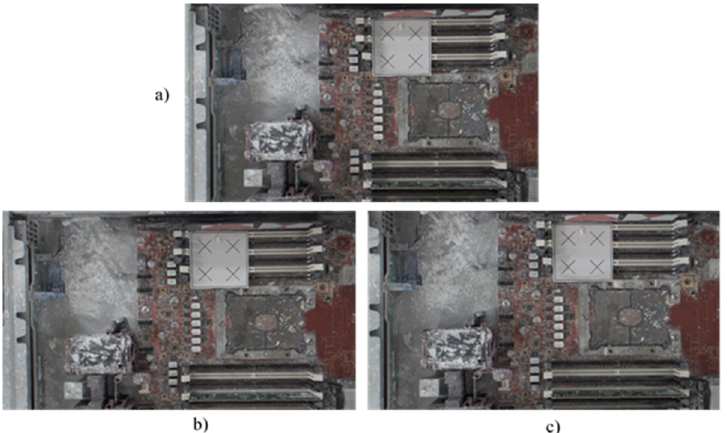
Figure 16. Position correction system test results for two random positions. Standard image without displacement or rotation corresponding to ( a ) Figure 14a, and new images after ( b ) the first random position shown in Figure 15a and ( c ) the second random position shown in Figure